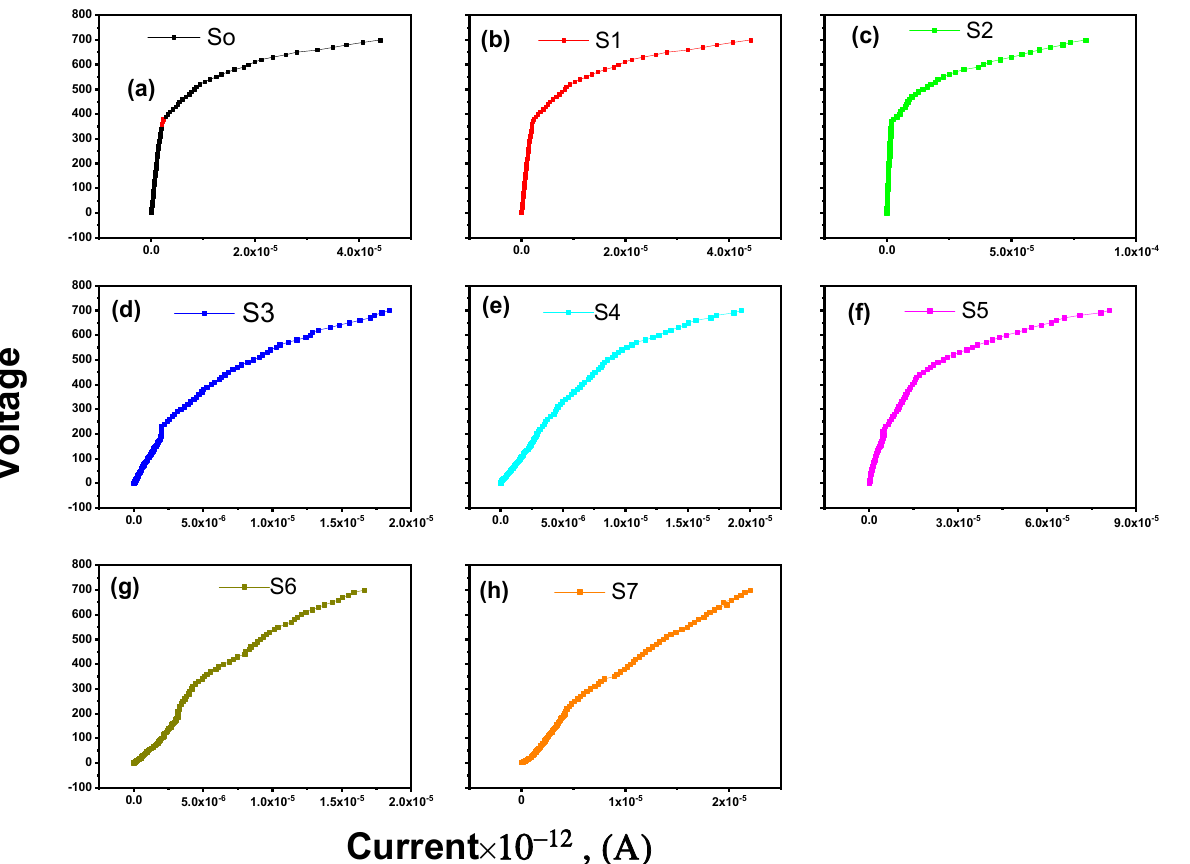
Figure 6. ( a - h ): V-I characteristics for the as-prepared La 2 O 3 -ZnO nanostructures. Nahm et al. observed that the knee-point voltage was sharper among the two zones